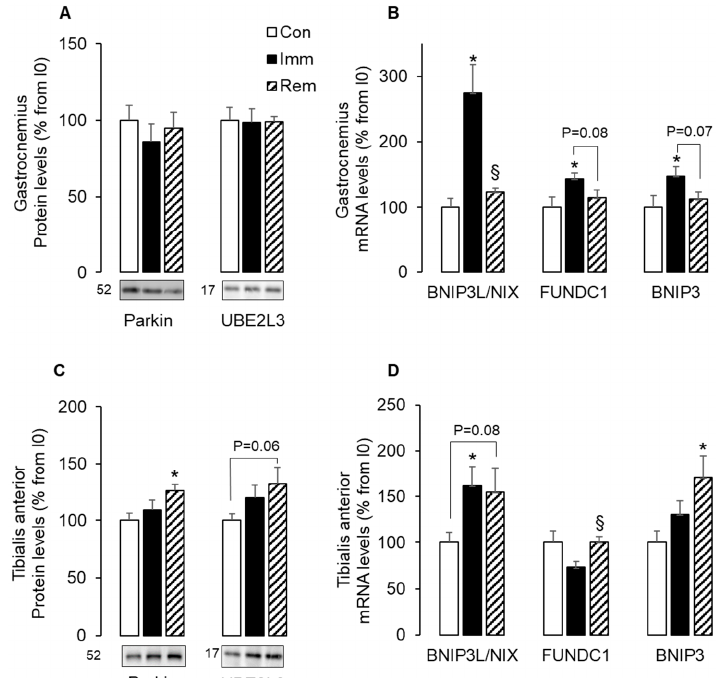
Figure 4. Parkin-dependent and independent mitophagy addressing pathways increased in the TA during remobilization. Protein levels for Parkin and UBE2L3 were assessed in the GA ( A ) and the TA ( C ) by Western blots, quantified and normalized using Ponceau red staining for uneven loading. Representative Western blots are shown below each graph, and molecular weights are given in kDa. mRNA levels for BNIP3L / NIX, FUNDC1, BNIP3 were measured in the GA ( B ) and the TA ( D ) by RTqPCR and were normalized using 18S rRNA. Data were expressed as % from the Con group. Statistical di ff erences were assessed by ANOVA, as described in Materials and Methods. * p < 0.05 vs. Con, § p < 0.05 vs. Imm; Con, non-immobilized rats; Imm, immobilized; Rem,